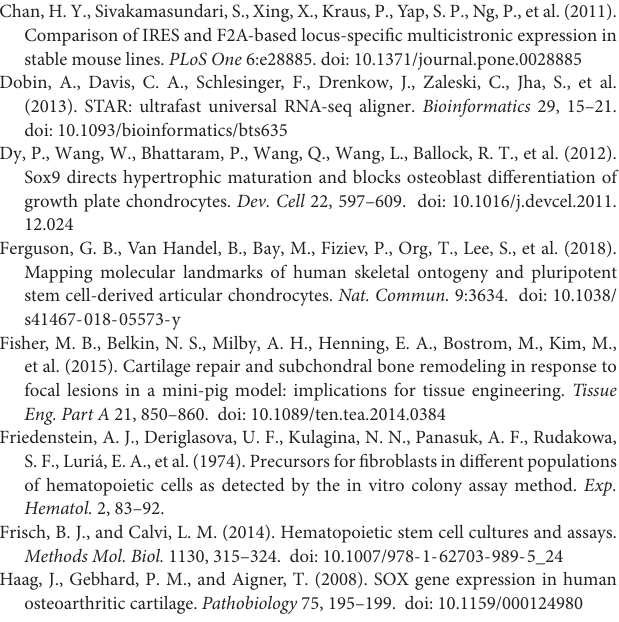
Supplementary Table 1 | qPCR primer sequences. Supplementary Table 2 | Antibodies used for